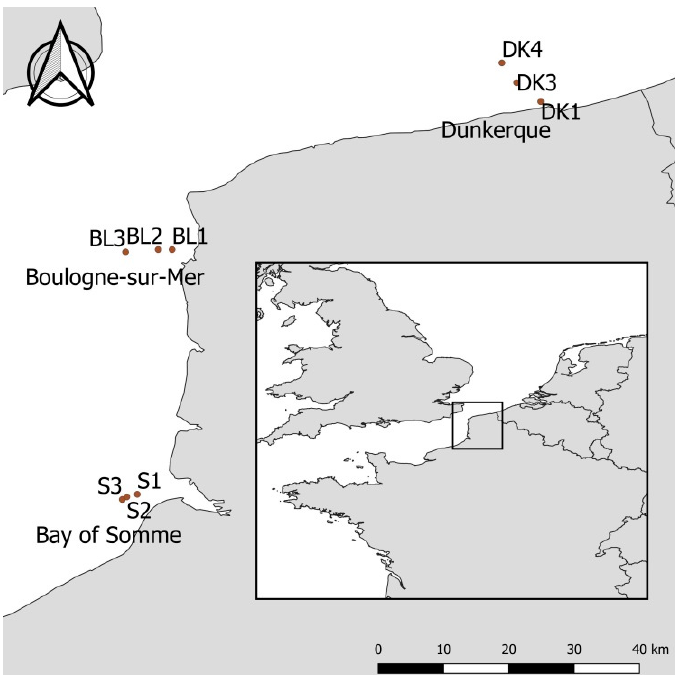
Figure 1. SRN network sampling stations located along the French coast in the eastern English Channel (Bay of Somme [S1, S2, S3] and Boulogne-sur-mer [BL1, BL2, BL3]) and in the Southern Bight of the North Sea (Dunkerque [DK1, DK3, DK4]). For each site, three sampling stations are sampled following a coastal–o ff shore